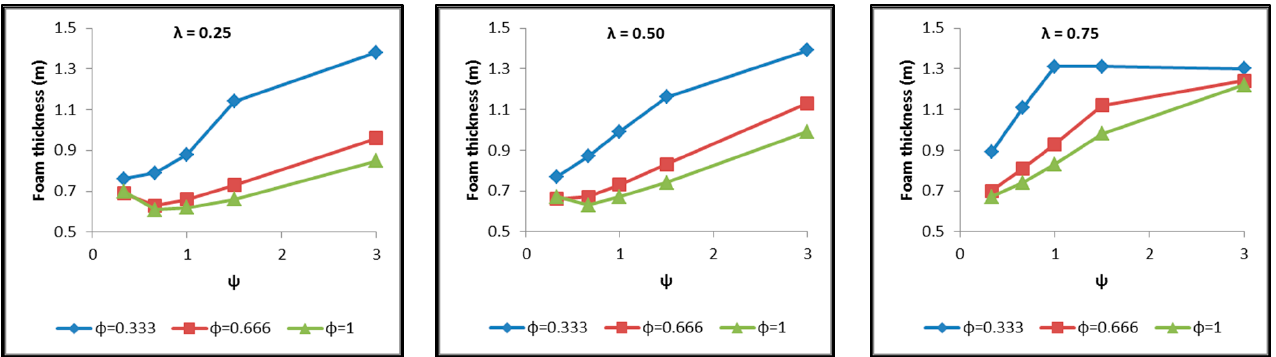
Figure 18. Distribution of the required insulating material thickness for maintaining the boil-off rate at 0.1%/hr as a function of the ratios λ , φ and ψ .